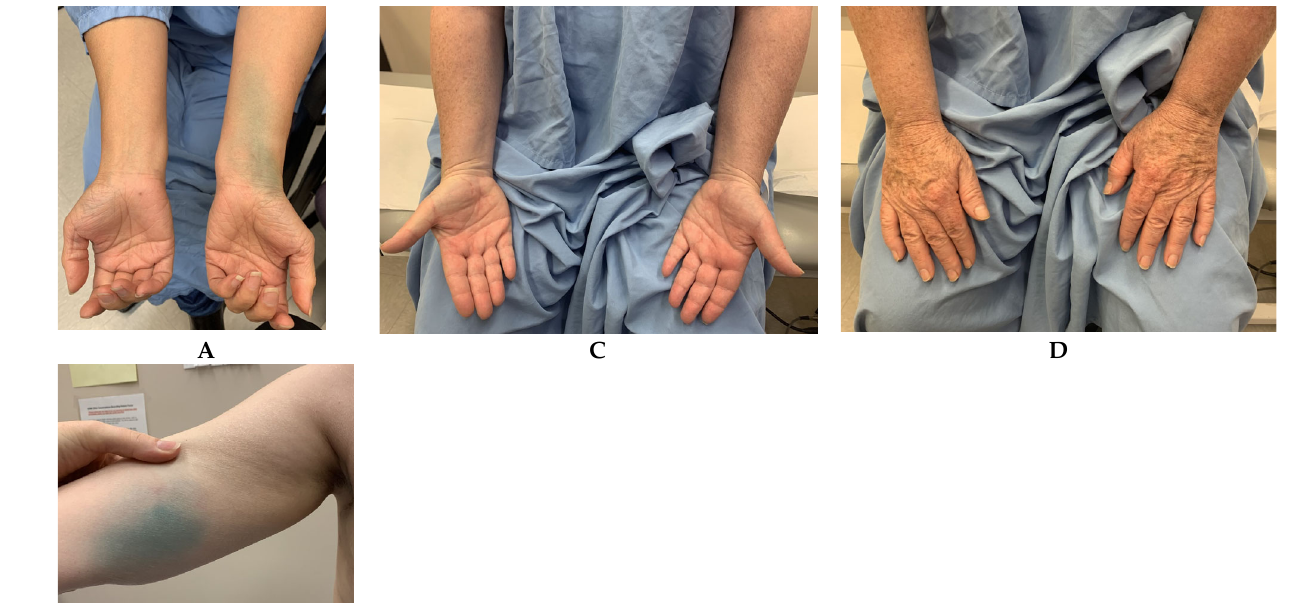
Figure 4. ( A ) : Initially, we placed the blue dye injection on the volar wrist. ( B ): Now, we inject the upper inner arm for better camouflage. ( C , D ): Volar and dorsal photos demonstrated no visible lymphedema. Comparative limb volumes in right to left arms are similar.